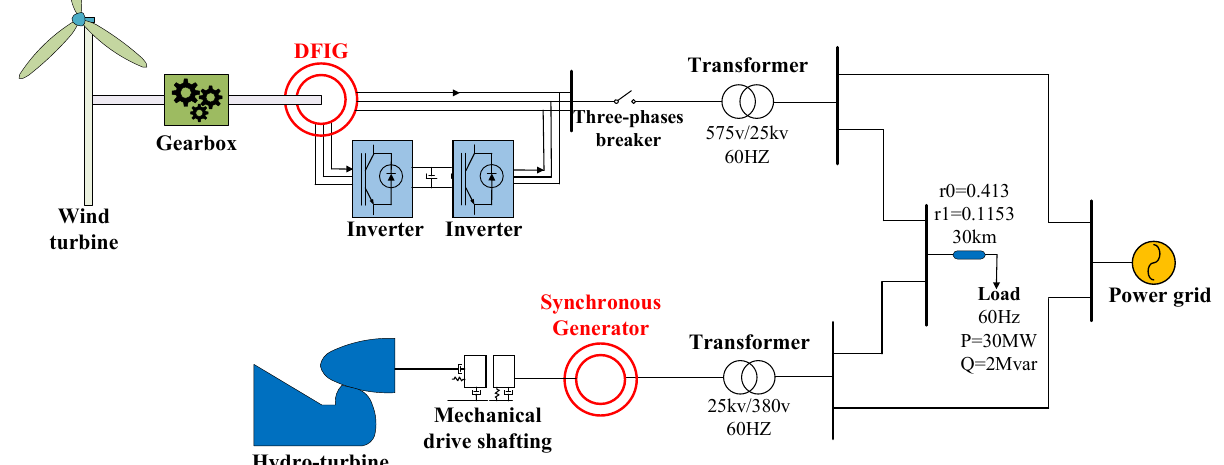
Figure 5. Block diagram of the grid-connected wind-hydropower integrated power system.